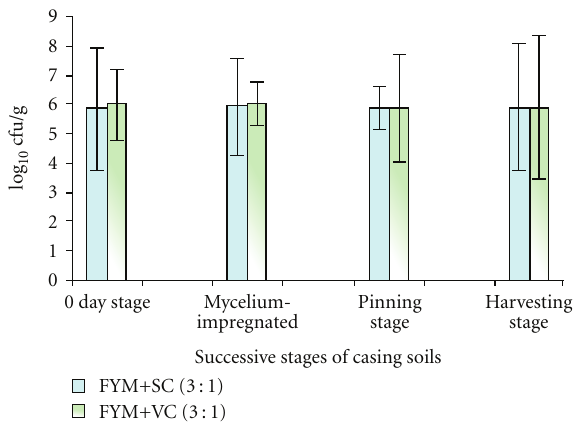
Figure 1: Total population count log philic bacteria on KBA from successive stages of casing